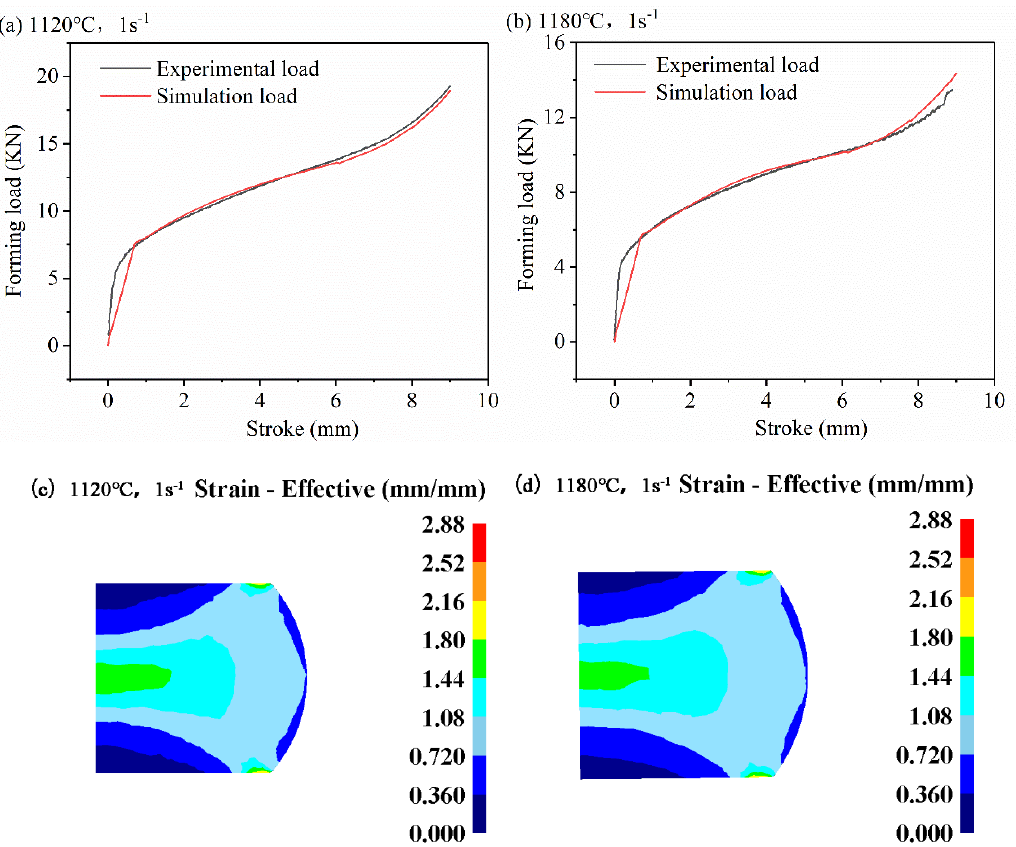
Figure 12. Numerical simulation results: Mold load at ( a ) 1120 °C, 1s −1 ( b ) and 1180 °C, 1s −1 strain distribution at ( c ) 1120 °C, 1 s −1 ( d ) and 1180 °C, 1 s −1.